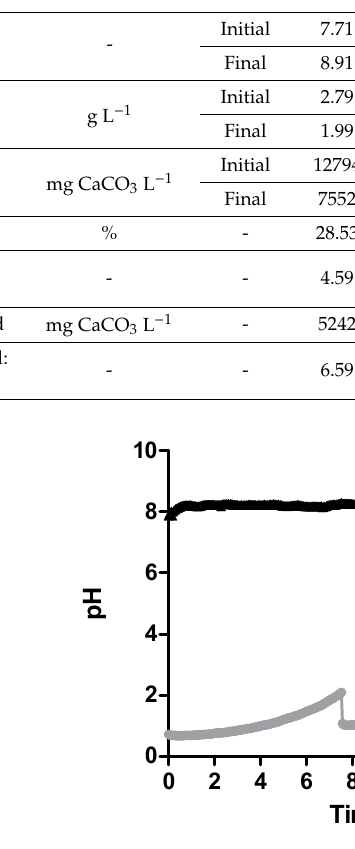
Figure 4. pH in the manure and in the acidic trapping solution during B3. Table 4. Chemical characterization of the trapping solution during the pilot plant operation. SD are shown in